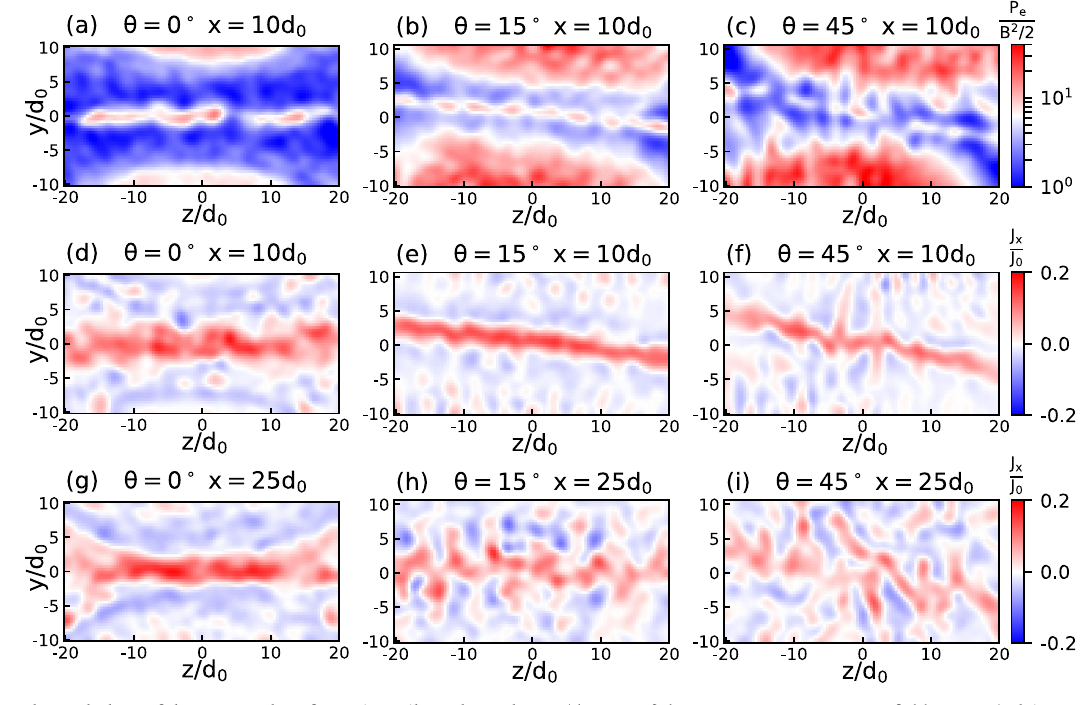
(theratioofelectronpressuretomagnetic fi eldpressure). d – i 2Dcuts(stillinthe yz plane) of the out-of-plane current J x at x =10 d 0 for panels d – f and at x =25 d 0 for panels g – i . All the images are retrieved from the 3D simulations, at t Ω 0